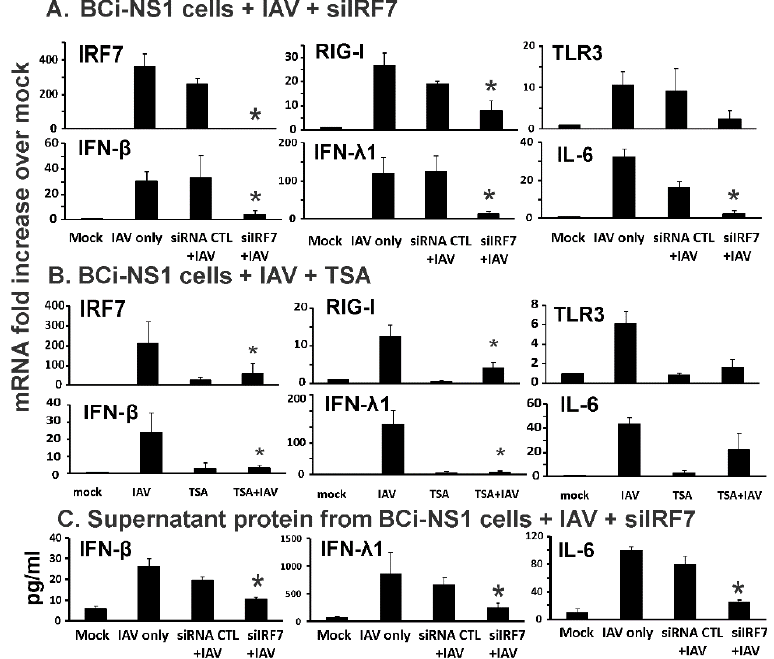
Figure 1. IRF7 knockdown by specific siRNA or chemical inhibition decreased